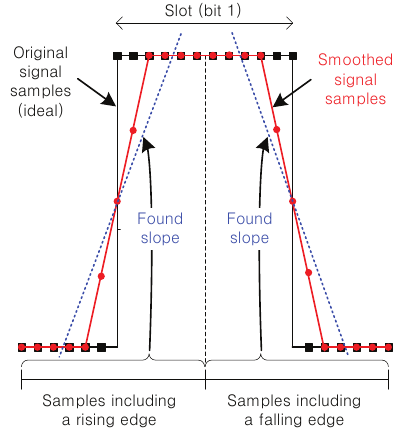
Figure 3. Illustration of signal-smoothing via moving average, and slope finding via first-order curve-fitting for ideal (fluctuation-free) signal